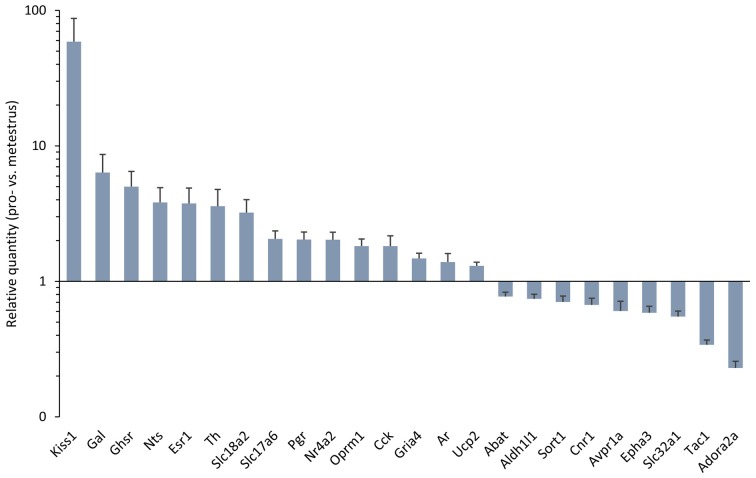
Differentially expressed genes in the antero-ventral periventricular/medial preoptic area (MPOA) of the late proestrous mouse. Relative quantity (RQ) values indicate the relative expression of genes in the pro- vs. metestrous experimental groups (p < 0.05, Student’s t-test). RQ values are visualized as a graph with log10 scale on the y axis.